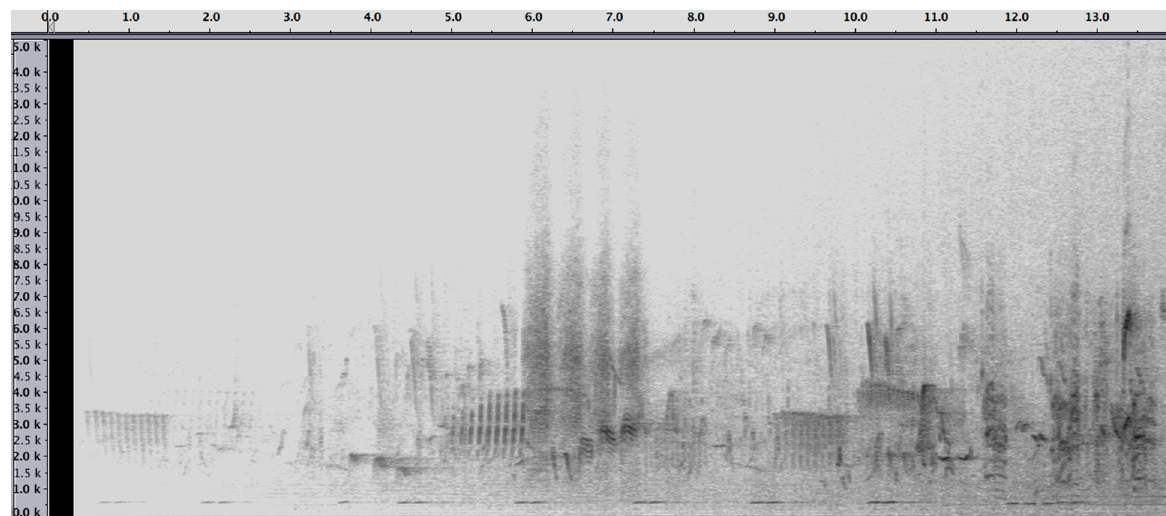
Figure 2. Spectrogram of about 13 s of the acoustic biotope of a typical African rain forest. Most of the sounds are animal sounds with both harmonic and inharmonic constituents.